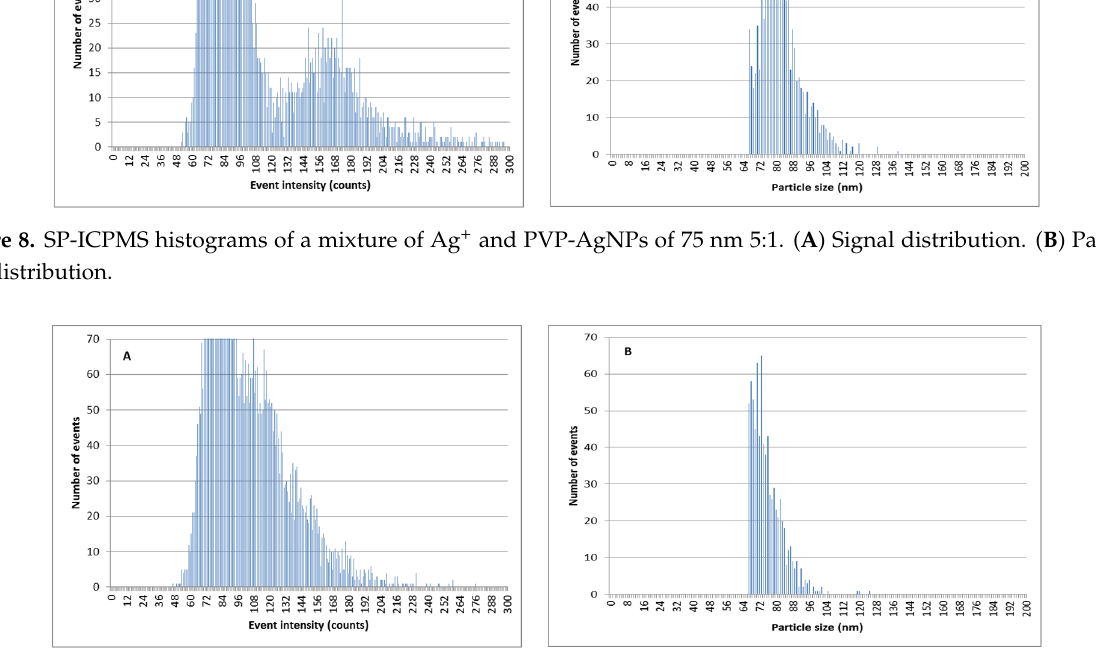
Figure 9. SP-ICPMS histograms of a mixture of Ag + and citrate-stabilized AgNPs of 60 nm 5:1. ( A ) Signal distribution. ( B ) Particle size distribution.